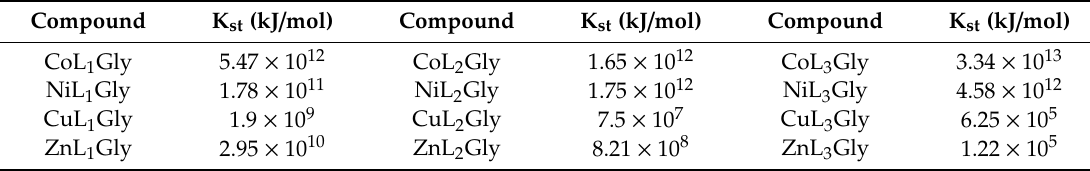
Table 2. Stability Constants of heteroleptic complexes (ML 1–3 Gly).